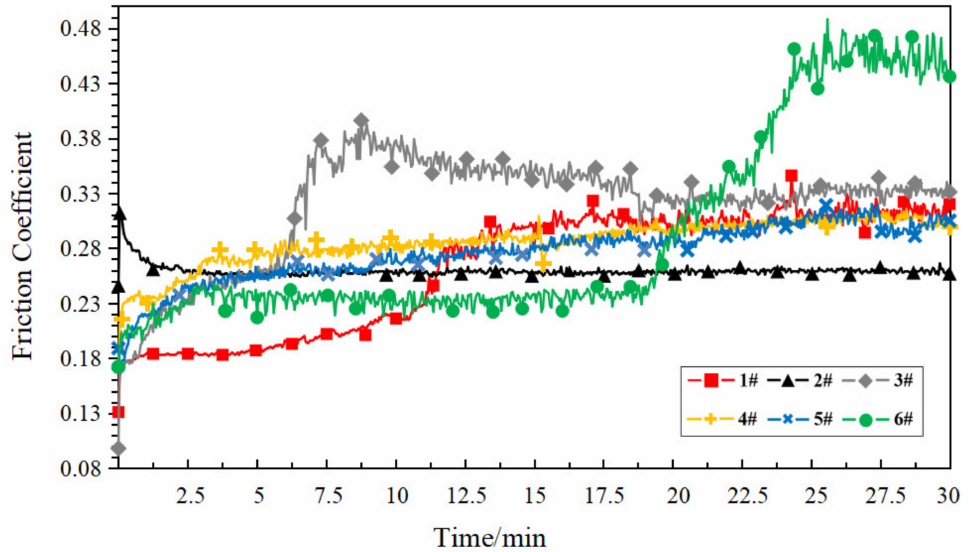
Figure 9. Friction coefficient curve of each heat-treated sample under the dry friction